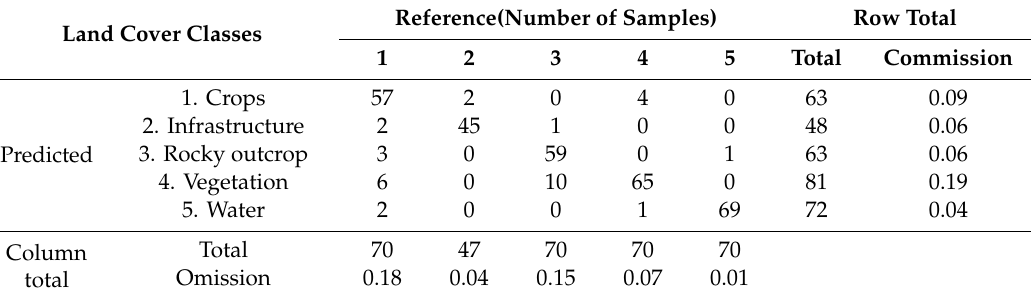
Table 4. Confusion matrix of land-cover